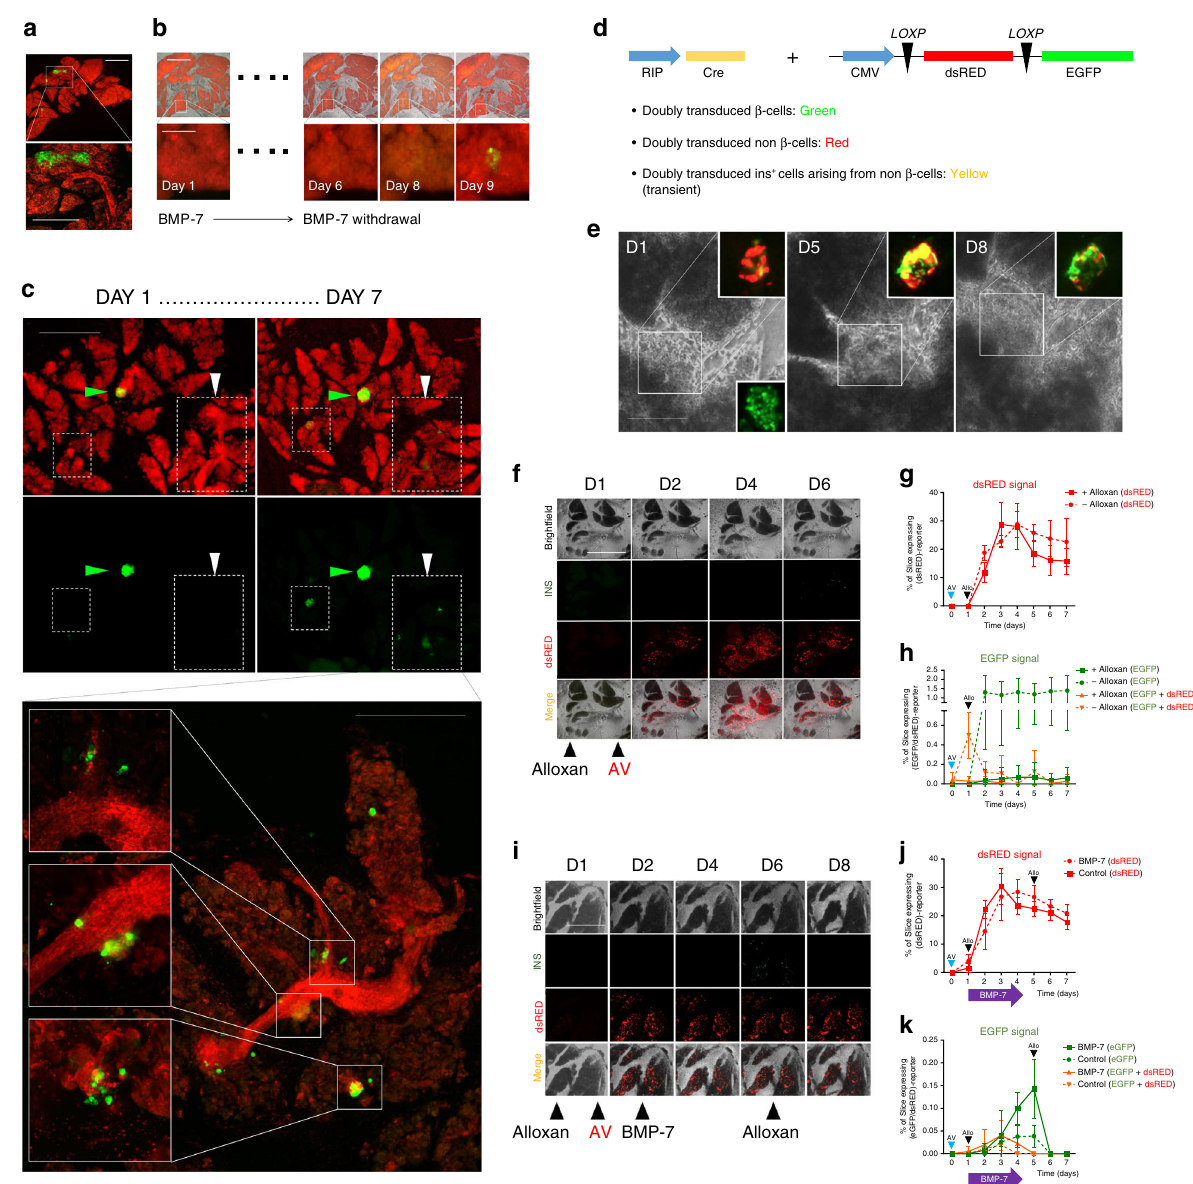
Fig. 4 Tracking of β -cell regeneration in murine pancreatic slices. a Representative microphotograph of murine pancreatic slices from Ins2-Cre.mTmG mice, with EGFP + insulin-producing cells (green) and all other cells tdTomato + (red). An islet and adjacent duct are magni fi ed in the inset. Scale 300 µ m. b Following 5 days of BMP-7 stimulation, removal thereof leads to insulin + cell formation at d9. Scale 300 µ m (magni fi ed insets: 50 µ m). c Representative microphotograph of murine slices from Ins2-Cre.mTmG mice treated for 7 days with THR-123. Green arrow shows a pre-existing islet. After THR-123 removal, new insulin + cells appear across the slice. Higher magni fi cation confocal imaging of the same region (lower panel) shows new insulin + cells sprouting from ducts. Scale 200 µ m; magni fi ed panel: 100 µ m. d Reporter strategy involving the co-transduction with adenoviral RIP-Cre tracer and lox/ dsRED/lox-EGFP reporter. Below are predicted outcomes depending on cell identity. e Representative microphotograph of CD1 mice-derived slices co- transduced as in d . BMP-7 is added for 5 days and then withdrawn. D1-d8 images show progressive appearance of insulin-expressing cells (green) from insulin – cells through an intermediate yellow (red + green) stage. Pre-existing islet-resident β -cells are EGFP-tagged within the fi rst 48 h of transduction, as shown in d1 inset. Scale 50 µ m. f Longitudinal imaging of CD1 mice-derived pancreatic slices transduced as in d . Alloxan was used to ablate β -cells at d1. No BMP-7 was added. Scale 500 µ m. g Expression of dsRED protein in transduced control slices over 7 days in alloxan-treated ( + ) and untreated ( − ) slices. h EGFP expression and co-localization of EGFP + dsRED in co-transduced alloxan-treated ( + ) and untreated ( − ) slices over 7 days. i Representative microphotograph of CD1 mice-derived slices co-transduced as in d . Slices were also treated with alloxan to ablate β -cells and subsequently exposed to BMP-7 from day 2 to day 4. Scale 500 μ m. j Quanti fi cation of dsRED expression in co-transduced, BMP-7-treated or control slices over 7 days in alloxan- exposed slices, showing no differences between groups. k Quanti fi cation of EGFP and co-localization of EGFP + dsRED (yellow) in co-transduced alloxan- exposed slices following treatment with BMP-7 (solid lines) or vehicle (dotted lines). Slices were challenged with alloxan a second time at d5, ablating new insulin + cells. Scale 500 µ m. For a – k , n = 5 biologically independent samples from individual mice. Data are presented as mean ± SD. Each n further represents the mean of three technical replicates, while plotted bars/lines are centered at mean. Source data are provided in the Source Data fi